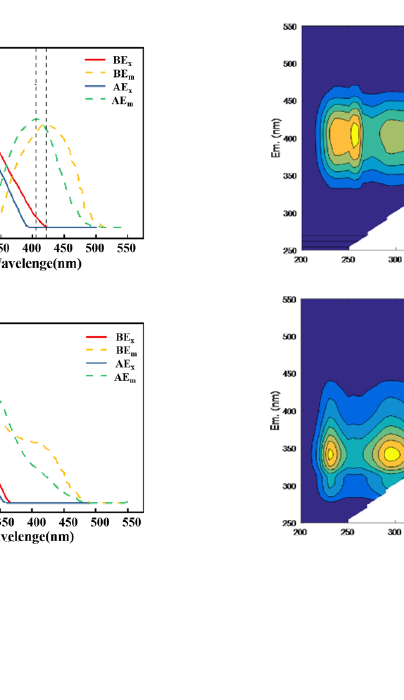
( C ) Figure 5. Output and verification results of the PARAFAC model of the DOM component fluores- cence spectrogram: ( A ) before degradation; ( B ) fluorescence loading; and ( C ) after degradation. ( A ) and ( C ): PARAFAC model output for fluorescent components: C1, short-wavelength fulvic-like sub- stances (terrestrial humic-like fluorescence peak A); C2, short-wavelength tryptophan-like sub- stances (protein-like fluorescence peak T2); C3, tryptophan-like substances (protein-like fluores- cence peak T1); and C4, tyrosine-like substances (protein-like fluorescence peak B1). ( B ): Load veri- fication results corresponding to the components; left peak: excitation wavelength load, right peak: emission wavelength load.